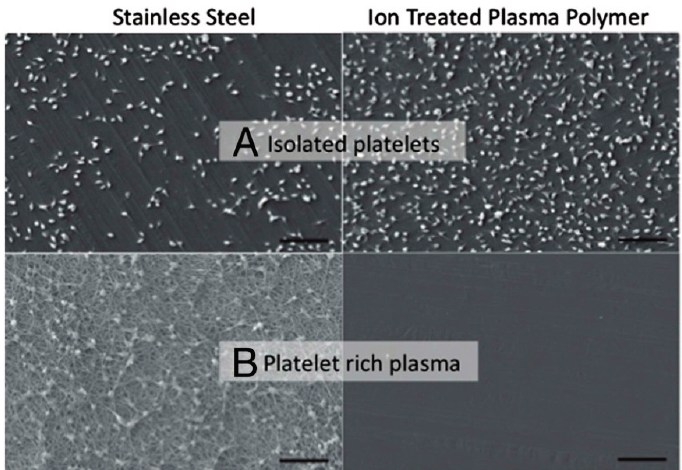
Figure 5. Isolated platelets in buffer adhering to both surfaces, but platelets in plasma do not adhere to ion treated polymer surface (scale bar = 20 μ m). Reprinted with permission from PNAS, 2011